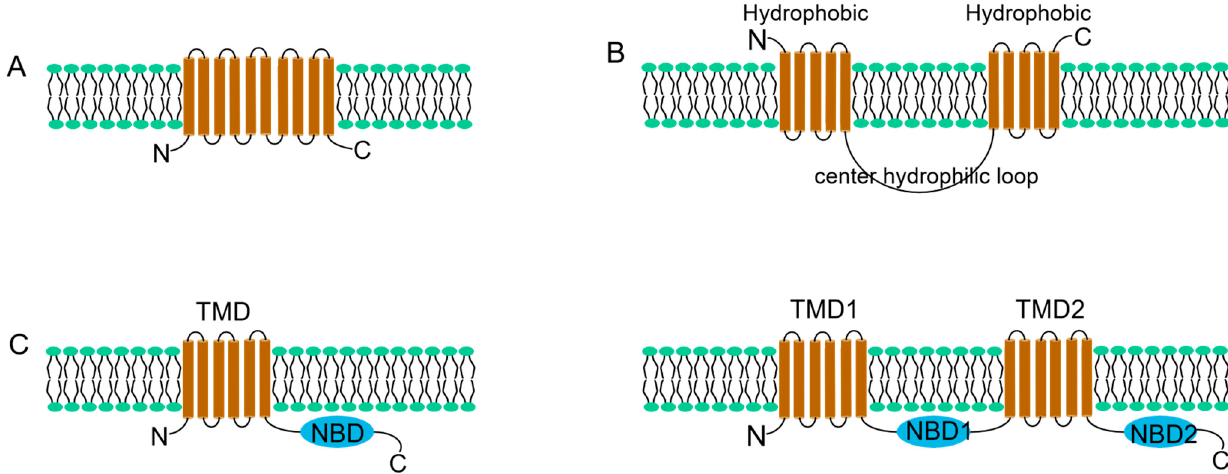
Figure 3. Structure model of protein. ( A ): Structure model of AUX protein. ( B ): Structure model of PIN protein. ( C ): Structure model of ABCB protein, Structural model of ABCB half-molecular transporter ( left ), Structural model of ABCB full-molecular transporter ( right ) (refer to Yu et al., 2015 [43]; Wang et al., 2008 [47]; Sánchez-Fernández et al., 2001 [48]).